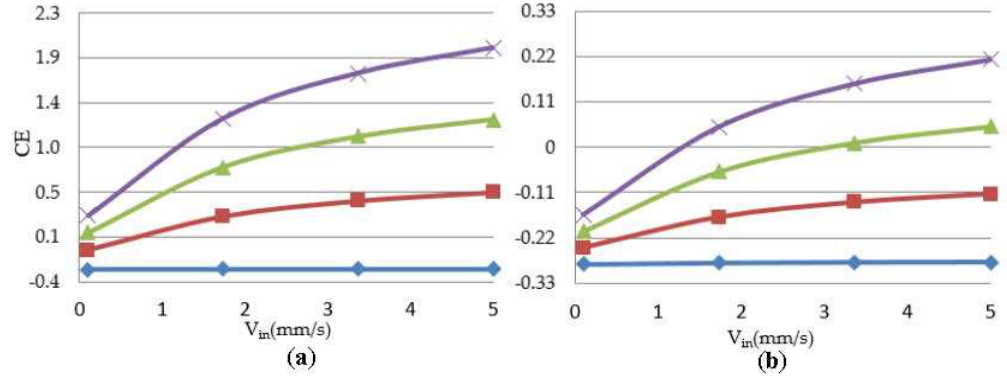
Figure 6. Correlation between cell culture efficiency vs. inlet perfusion velocity within the studied unit. Gl in = 0.059 × 10 −3 g/cm 3 , initial cell density = 2 × 10 7 cells/cm 3 ; ( b ) initial cell density = 10 × 10 7 cells/cm 3 .